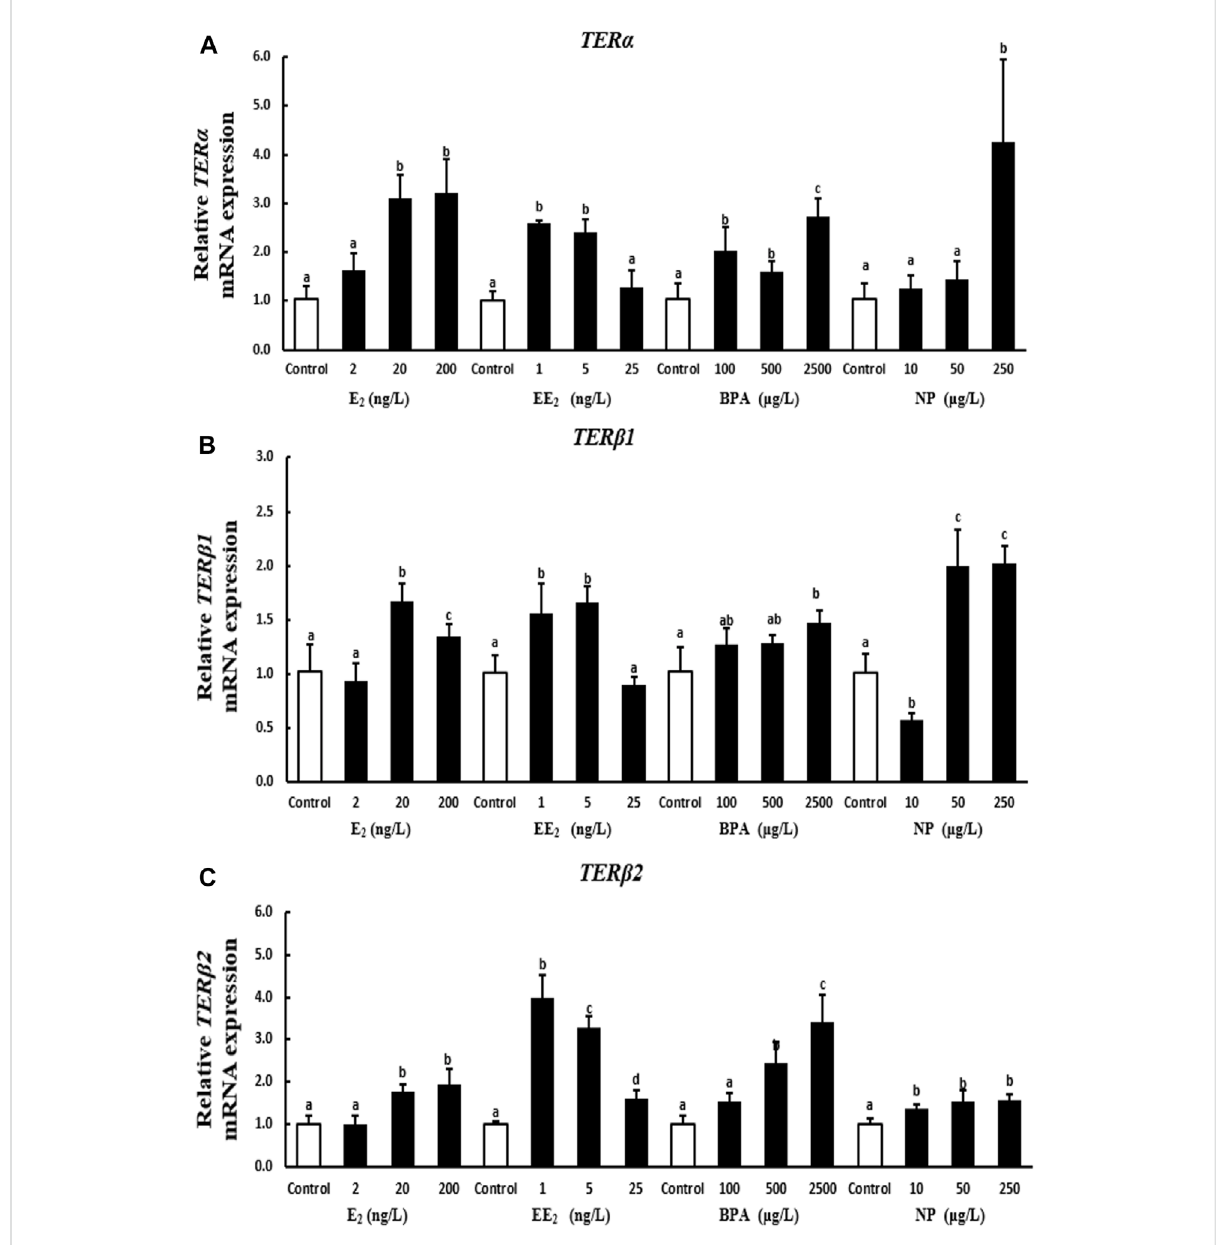
FIGURE 4 Effects of EDCs on the expression of ter α (A) , ter β 1 (B) , and ter β 2 (C) in the testis of T. albonu bes. Columns with different letters represent the signi fi cant difference at p < 0.05 according to one-way ANOVA followed by Dunnett ’ s